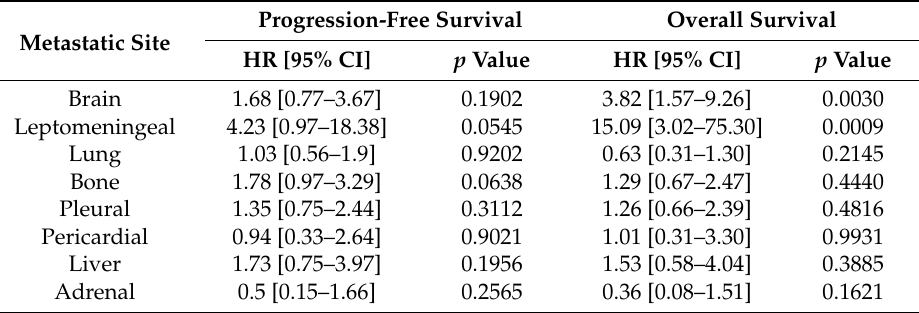
Table A3. Univariate Cox proportional hazards regression analysis to identify the relationship between metastatic sites and survival in patients with stage IV lung cancer harboring rare mutations receiving first-line